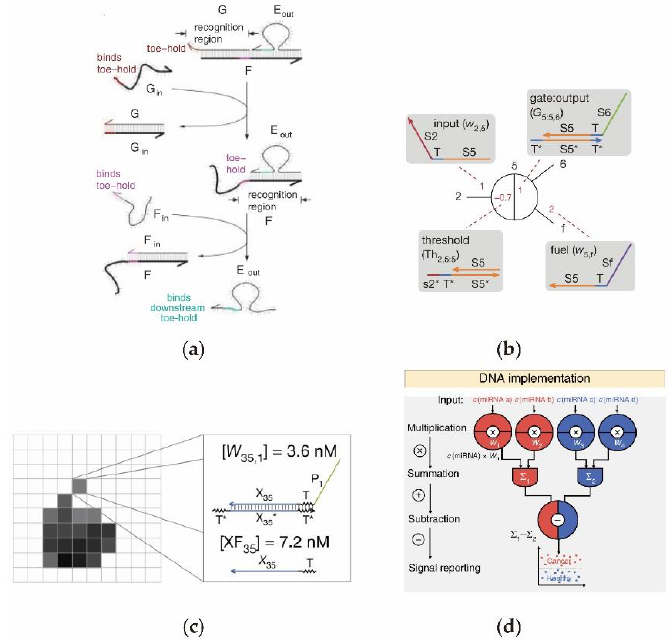
Figure 1. Cascade circuit to perform neural networks. ( a ) Schematic diagram of the DNA cascade circuit based on creating toehold sites. ( b ) Structure of DNA circuit neurons with weights and thresholds comprised of DNA strands, where multi-input and multi-output functions are per- formed. ( c ) Schematic diagram of the DNA neural network circuit to implement handwritten char- acter recognition system. ( d ) The neural network computing model designed using the DNA cas- cade circuit to classify and identify Cancer. 2.2. Enzyme-Free Catalytic DNA Circuit In natural gene networks, protein enzymes are typically used as catalysts, while DNA seldom performs a catalyzing function. This means that the input DNA signals are con- tinuously consumed in a normal noncatalytic DNA circuit reaction, thus leading to a lim- ited reaction efficiency. In synthetic DNA circuit, by introducing a recyclable DNA as a catalyst the reaction efficiency is greatly improved, and only a small amount of input DNA is required to release a large amount of output DNA [56]. Therefore, a catalytic DNA cir- cuit can be used to construct a more efficient artificial nucleic acid system without the use of a bioenzyme. In 2006, Seelig et al. [57] first proposed a DNA circuit with high catalytic efficiency based on DNA strand replacement by establishing a catalytic cycling unit. Figure 2a illus- trates the operation of this enzyme-free catalytic circuit based on the principle of DNA displacement. Without a catalyst strand in the system, because the structure of S — L itself is a relatively stable double-stranded structure, the input L — displaces the output S — from L at a slower rate. Once the catalyst strand is added to the original system, the hybridization between the catalyst strand and L will be triggered immediately to reduces the stability of SL, thus greatly increasing the reaction rate of L — to S — through DNA displacement. It should be noted that a single catalyst strand can be used repeatedly in each cycle of this enzyme-free catalytic reaction, as a small amount of the catalyst can result in the system possessing a high catalytic efficiency. Since the linear DNA structure is more stable and easily transformed, Zhang et al. [58] designed an enzyme-free DNA circuit with a high catalytic performance, using single-stranded DNA as a catalyst. As shown in Figure 2b, the DNA catalyst was used repeatedly in the catalytic cycle without being consumed, and